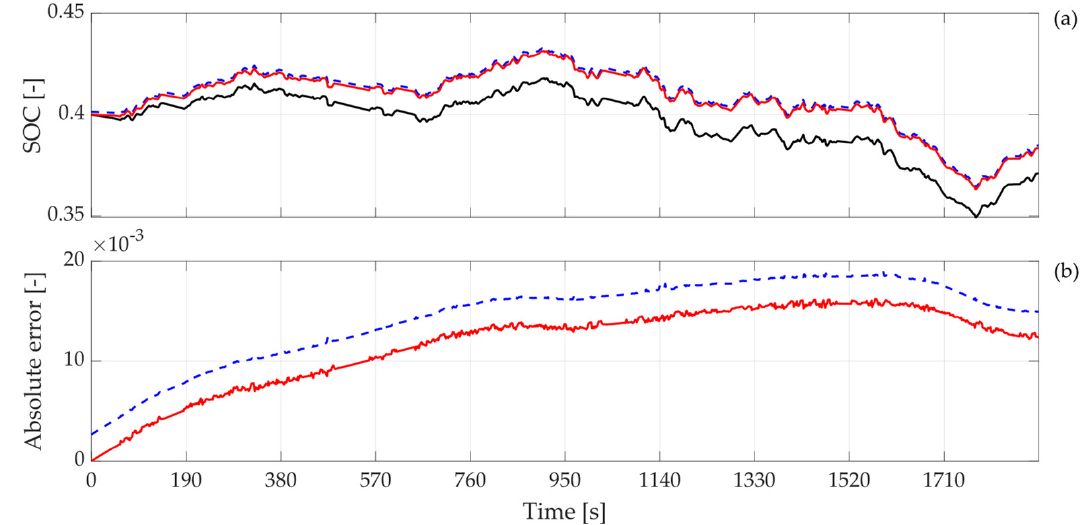
Figure 12. Results on testing dataset B—NARX RNN layout 1: ( a ) reference SOC (solid black line) vs. simulation estimated SOC (solid red line), HIL estimated SOC (blue dashed line) ( b ) simulation absolute error (red solid line), HIL absolute error (magenta dashed line).